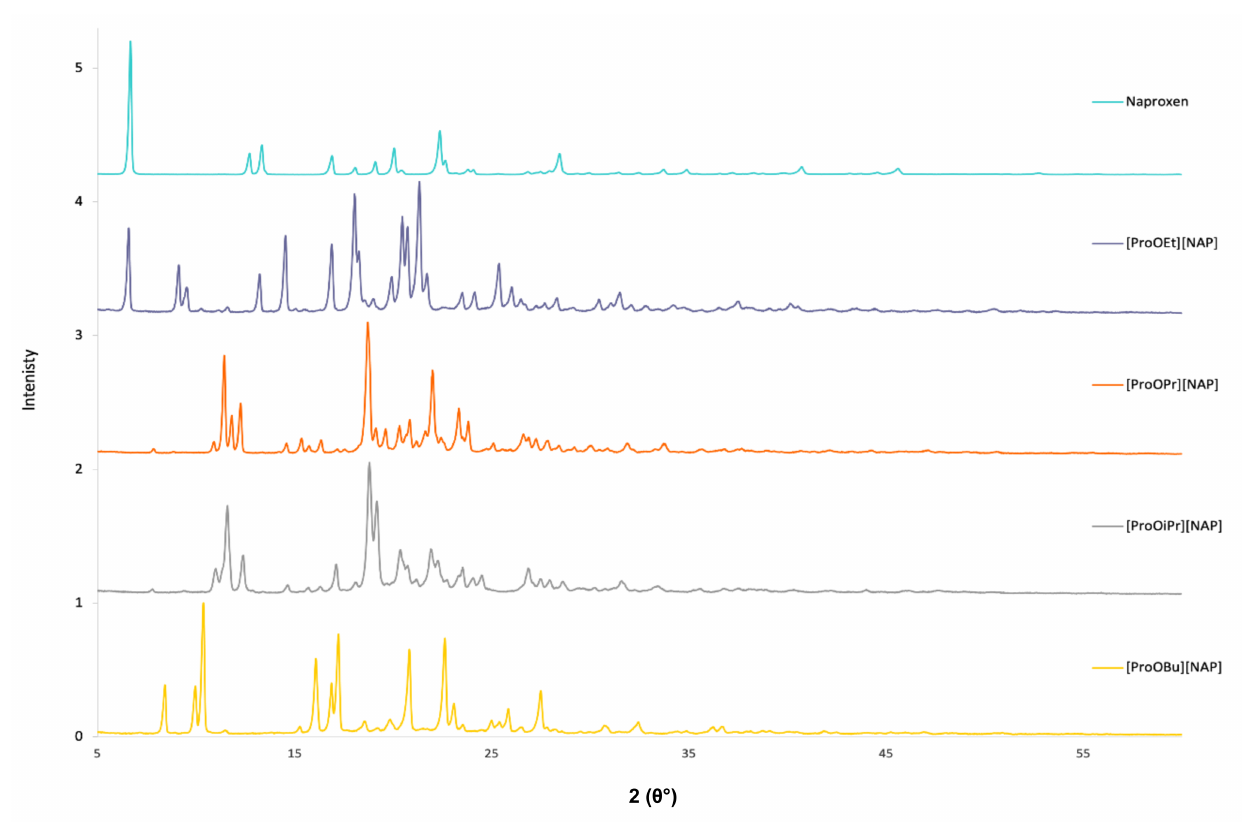
Figure 4. X-ray diffraction patterns of naproxen (lith blue), [ProOEt][NAP] (navy blue), [ProOPr][NAP] (orange),